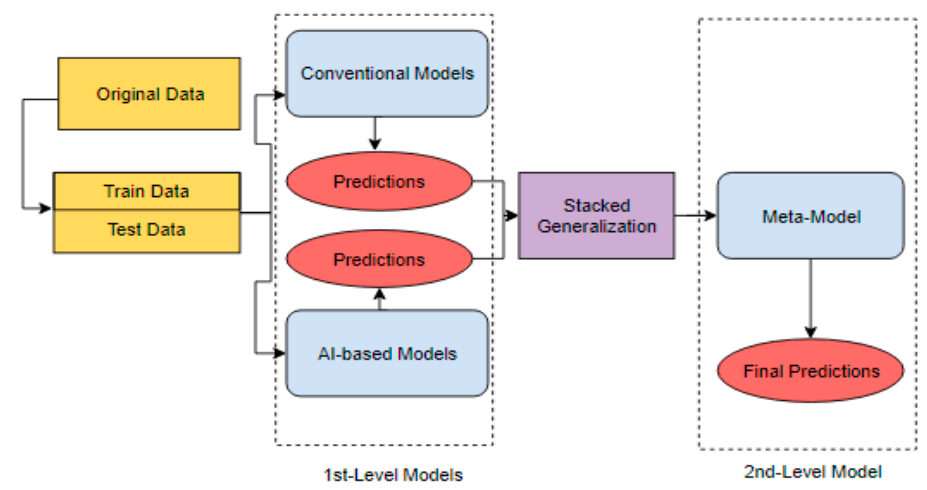
Figure 3. The architecture of elaborated models. Source, authors own elaboration.